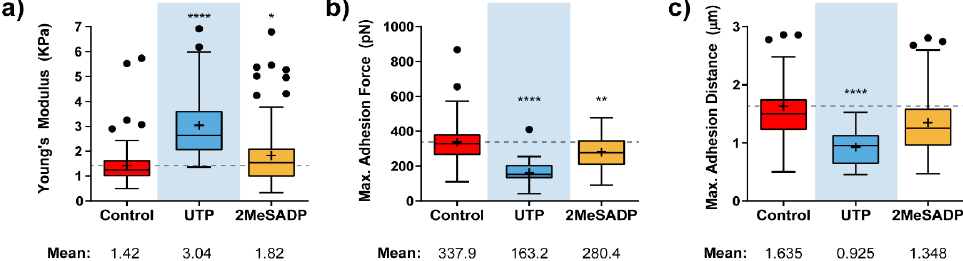
Figure 1. Effects of nucleotide stimulation of HUVECs on some mechanical parameters. Calculated instantaneous Elastic modulus ( a ) and adhesion-related ( b , c ) value variation for HUVEC cells ( N > 15) exposed to UTP (blue), and 2MeSADP (yellow) agonists. Boxplots cover the range 25–75%, being the horizontal line indicative for the median, and the cross for the mean value, which are shown numerically below. For comparative purposes, a horizontal dashed grey line indicates control mean values. Whiskers indicate 5 and 95 %, while black dots refer to outliers. Statistically relevant variations p < 0.05, p < 0.01 and p < 0.0001 are highlighted by *, ** and ****, respectively.